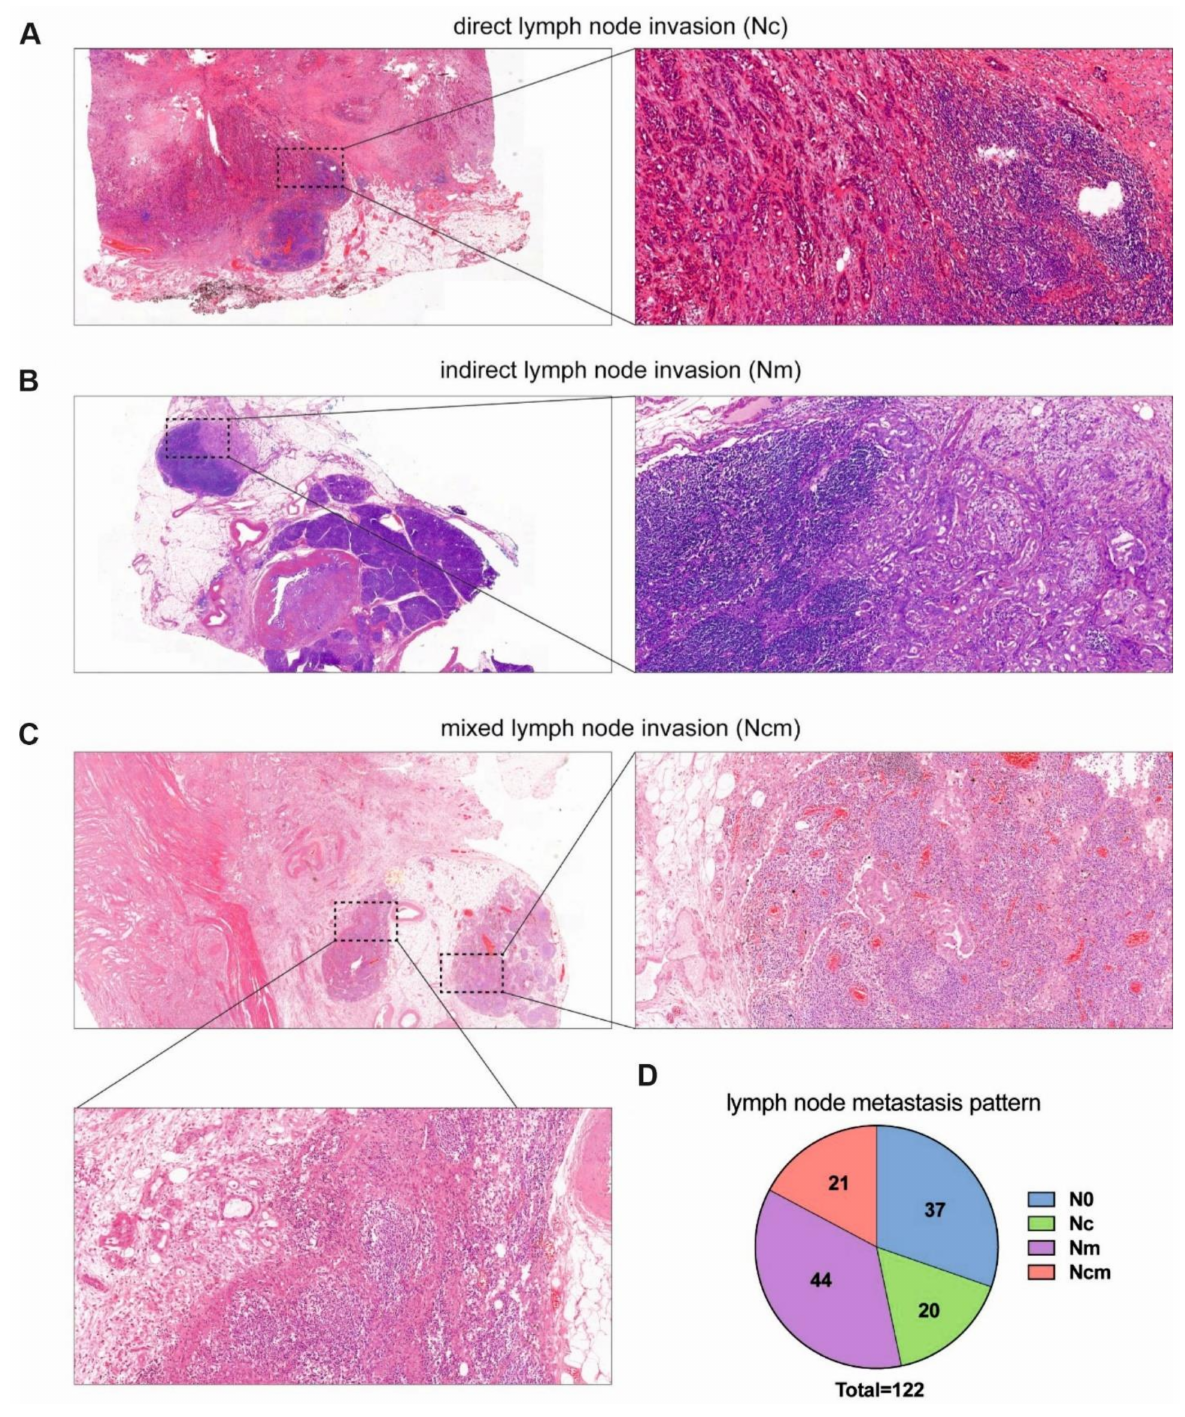
Figure 1. Histological sections with haematoxylin–eosin staining (at 20x magnification and the zoom-in cassettes at 100x magnification) of the different types of lymph node invasion in pancreatic ductal adenocarcinoma: ( A ) direct lymph node invasion by the main tumour per continuitatem, Nc; ( B ) indirect lymph node invasion without any contact to the main tumour, Nm; ( C ) Mixed lymph node invasion, Ncm; ( D ) pattern of the different lymph node types in our